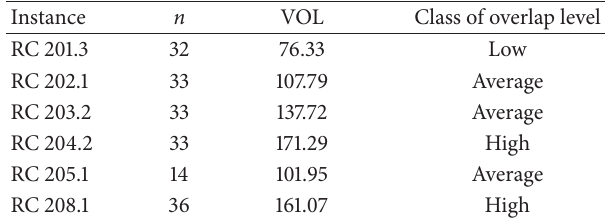
Table 3: Selected problem